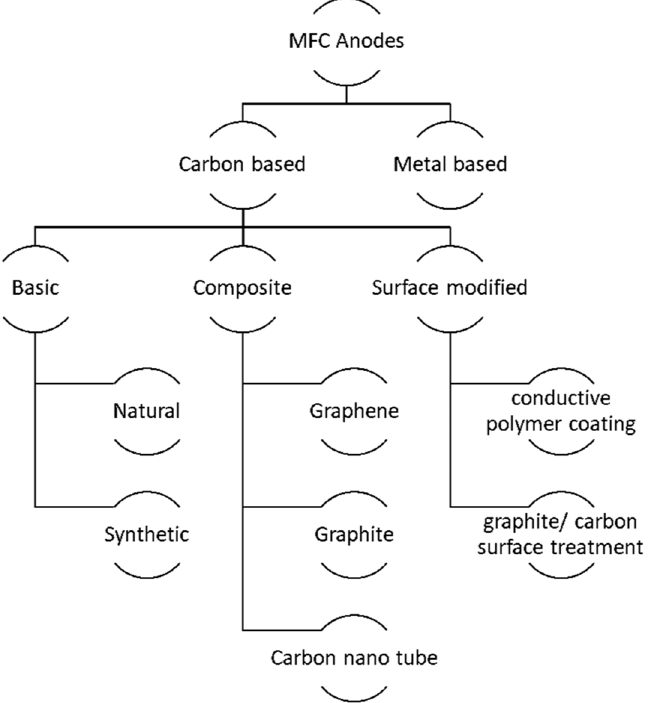
Figure 4. Classification of MFC anodes according to their structural configuration.